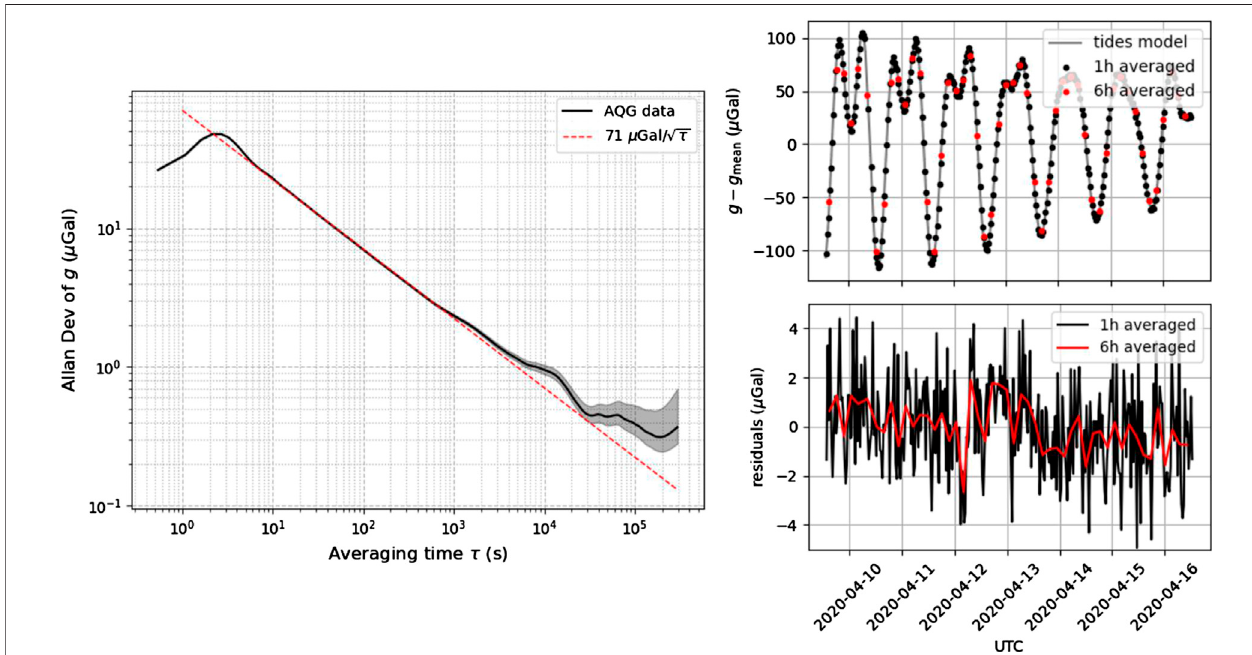
FIGURE9 | Resultsfroma1-weekcontinuousgravitymeasurementinTalence,France,inApril2020. Left: Allandeviationofgravityresiduals.Sensitivityis71 µGal/ √ t and stability over averaging times longer than 10 4 s is below 1 µGal. Top right: raw measurements, averaged over 1 h (black dots), 6 h (red dots) and the local tide model (solidline). Bottom right: gravity residuals after correctionfor tidaleffectsand atmosphericpressure.Standard deviation for a1 h (6 h) averaging timeis1.9 µGal(1.0 µGal).